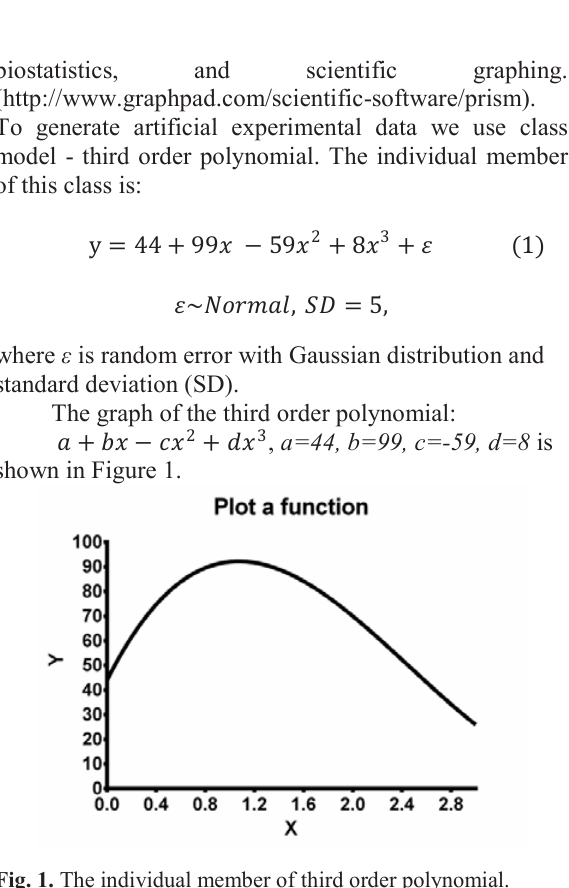
Fig. 1. The individual member of third order